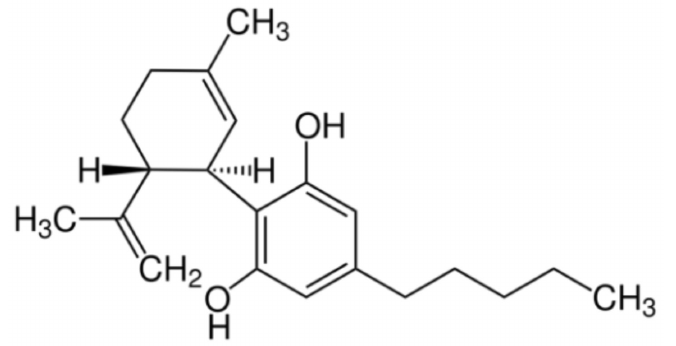
Figure 1. Chemical structure of cannabidiol